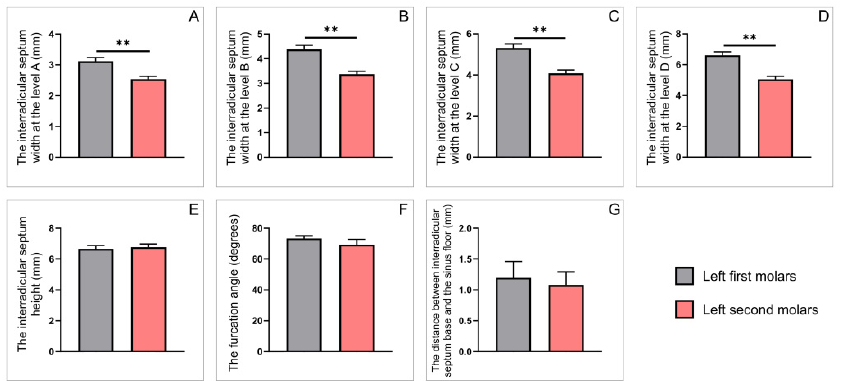
Figure 5. The parameters obtained on sagittal slices for upper molars on the left side: ( A – D ) the interradicular septum width (in mm) at the levels A–D, respectively; ( E ) the interradicular septum height (in mm); ( F ) the interradicular furcation angle (in degrees); ( G ) the distance between interradicular septum base and the sinus floor (in mm). Values are expressed as the mean ± SEM. ** Denotes a significant difference, p < 0.01.